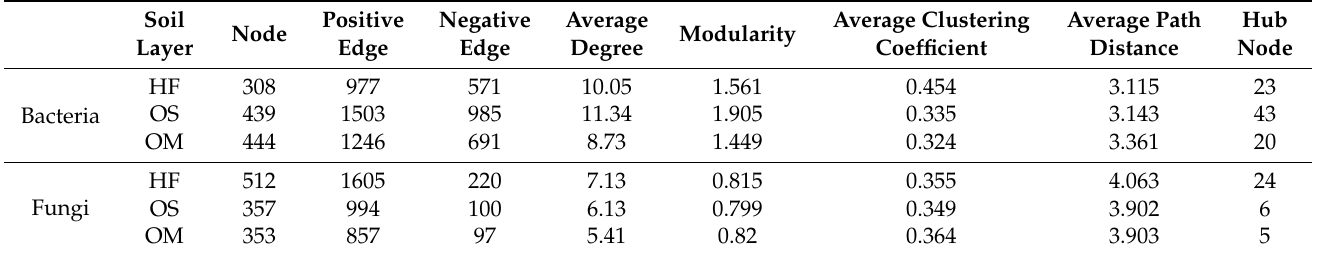
Figure 2. Bacterial and fungal co-occurrence network along soil layers based on all samples. For visual clarity, only amplicon sequence variants (ASVs) that were detected to be present in 95% and 20% of all samples for bacteria and fungi are illustrated. HF: humic fragmented litter, OS: organic soil, OM: organic mineral soil.